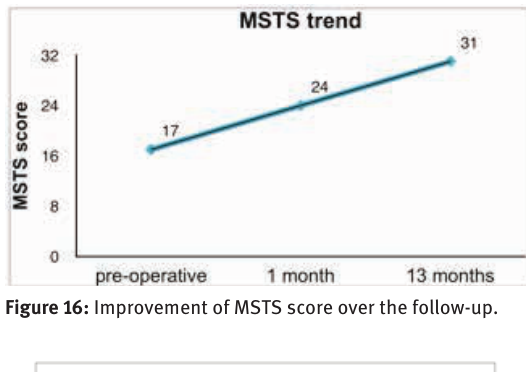
Figure 15: Decrease of VAS score over the follow-up.